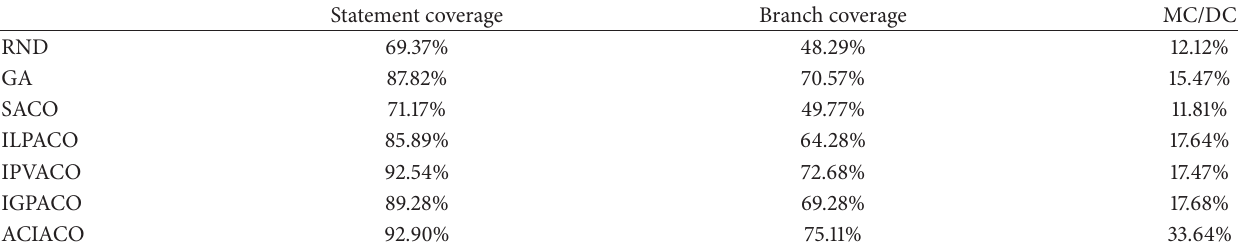
Table 5: Coverage of TCAS by seven approaches.